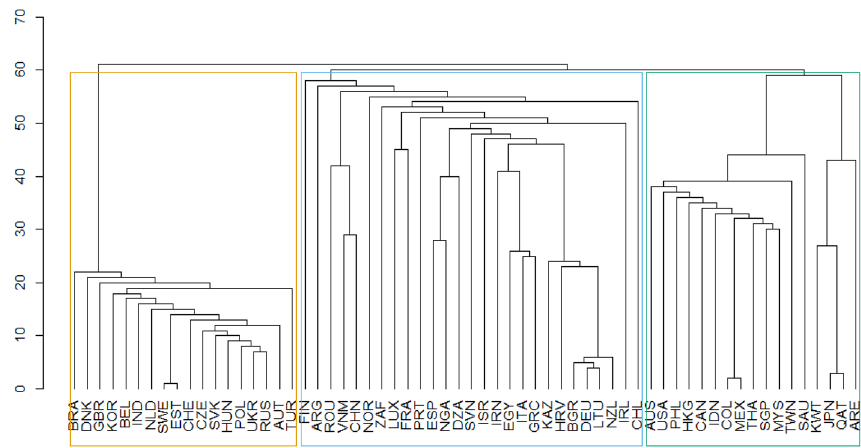
Fig. 5 Community detection. The left axis of the dendrogram shows the maximum density links between countries after pairing (Source: Own elaboration with EORA